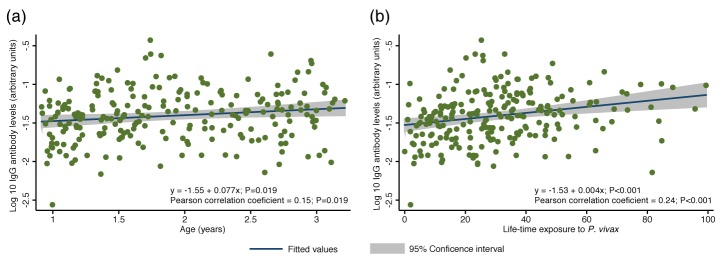
Association between cumulative IgG levels to 38 P. vivax proteins and exposure to P. vivax infections in Papua New Guinean children aged 1–3 years.(a) Association with age. (b) Association with lifetime exposure. For each child, exposure was defined as the total number of P. vivax blood-stage clones acquired per time-at-risk (molFOB), and lifetime exposure as a product of age and molFOB. n = 225. P values < 0.05 were deemed significant.10.7554/eLife.28673.005Figure 2—source data 1.Associations between IgG to P. vivax antigens with measures of concurrent and cumulative exposure in Papua New Guinean children aged 1–3 years.Geom mean = geometric mean. Exposure was defined as the total number of P. vivax blood-stage clones acquired per time-at-risk (molFOB) and lifetime exposure as age multiplied by molFOB. Geometric mean IgG levels and 95% intervals are in arbitrary units interpolated form standard curves using a 5PL logistic regression model and were multiplied by 1000. For age and lifetime exposure, rho (r) and P values were calculated using Spearman's rank test. For infection status, IgG levels were log10 transformed and P values calculated using unpaired 2-tailed t tests. P values < 0.05 were deemed significant.